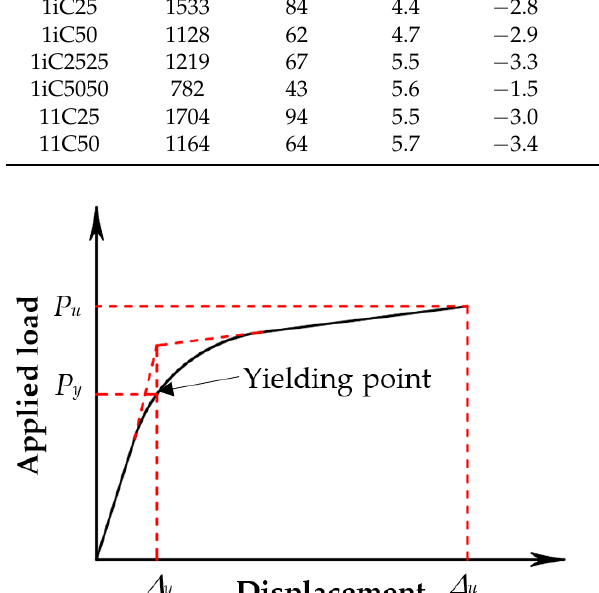
Figure 10. Yielding point definition.